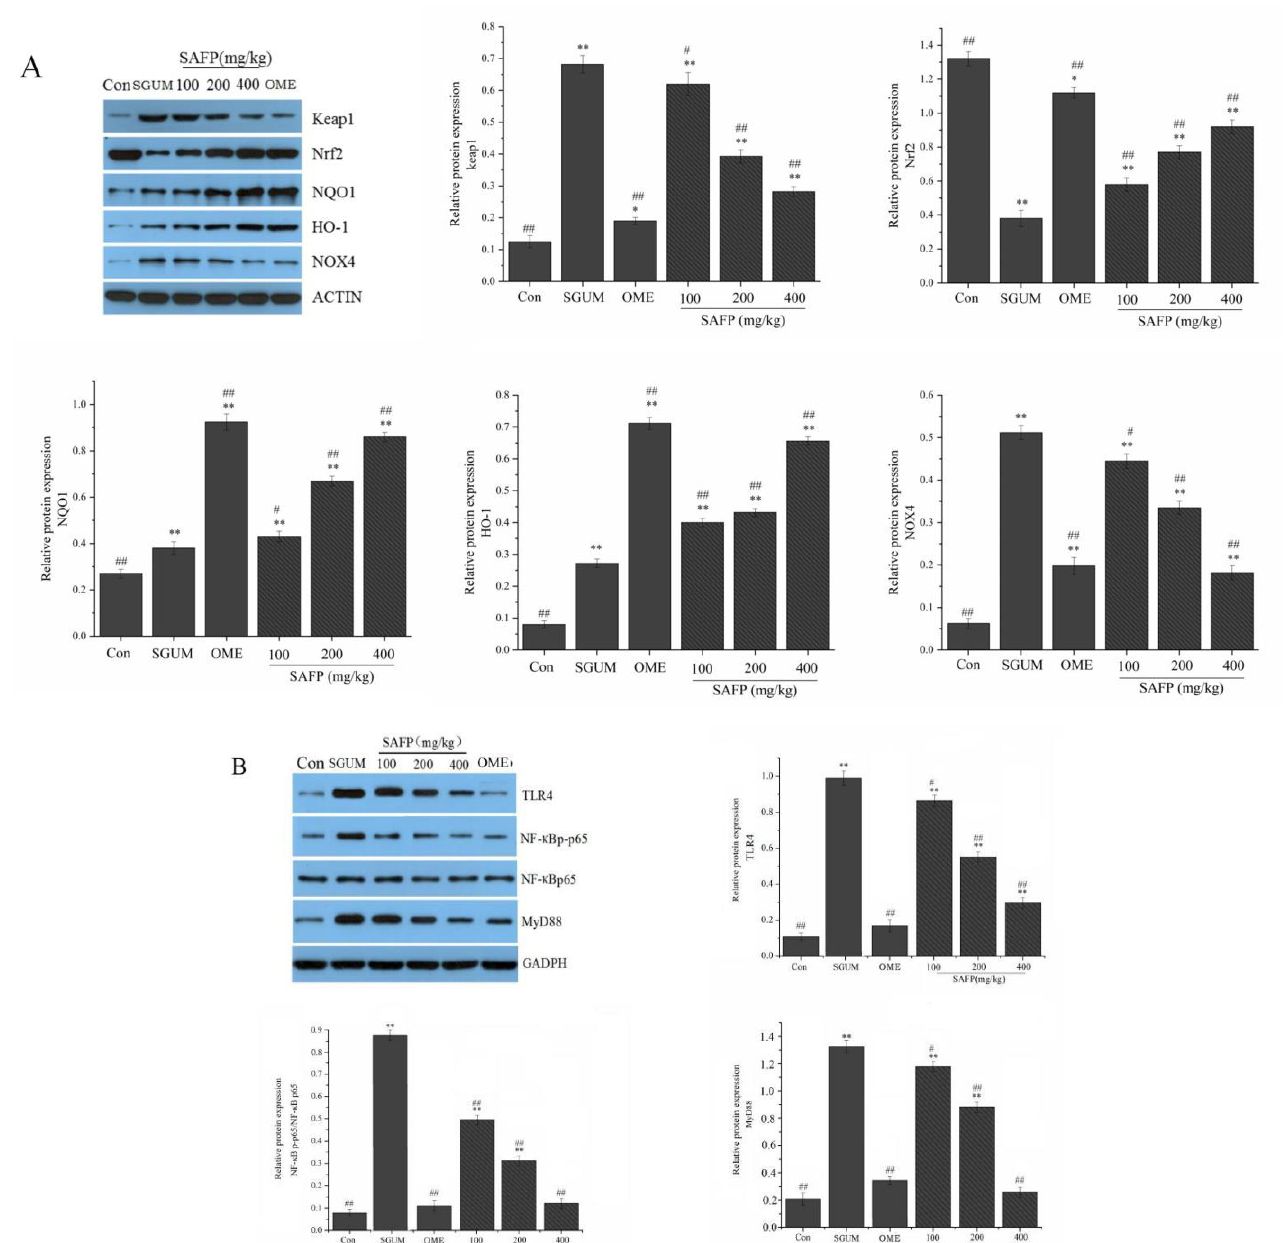
Figure 5. Immunohistochemical assay. ( A ) Expression of Keap-1 by immunohistochemical staining and statistical analysis of Keap-1. ( B ) Expression of Nrf2 by immunohistochemical staining and sta- tistical analysis of Nrf2. ( C ) Expression of TLR4 by immunohistochemical staining and statistical analysis of TLR4. ( D ) Expression of NF-κBp-p65 by immunohistochemical staining and statistical analysis of NF-κBp-p65. Data are represented by mean ± SD ( n = 10). * p < 0.05, ** p < 0.01 vs. control group. # p < 0.05, ## p < 0.01, vs. SGUM group.